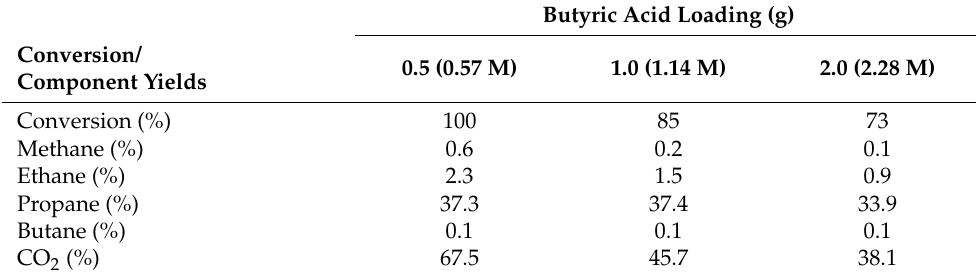
Table 4. Effect of butyric acid loading on butyric acid conversion and gas product